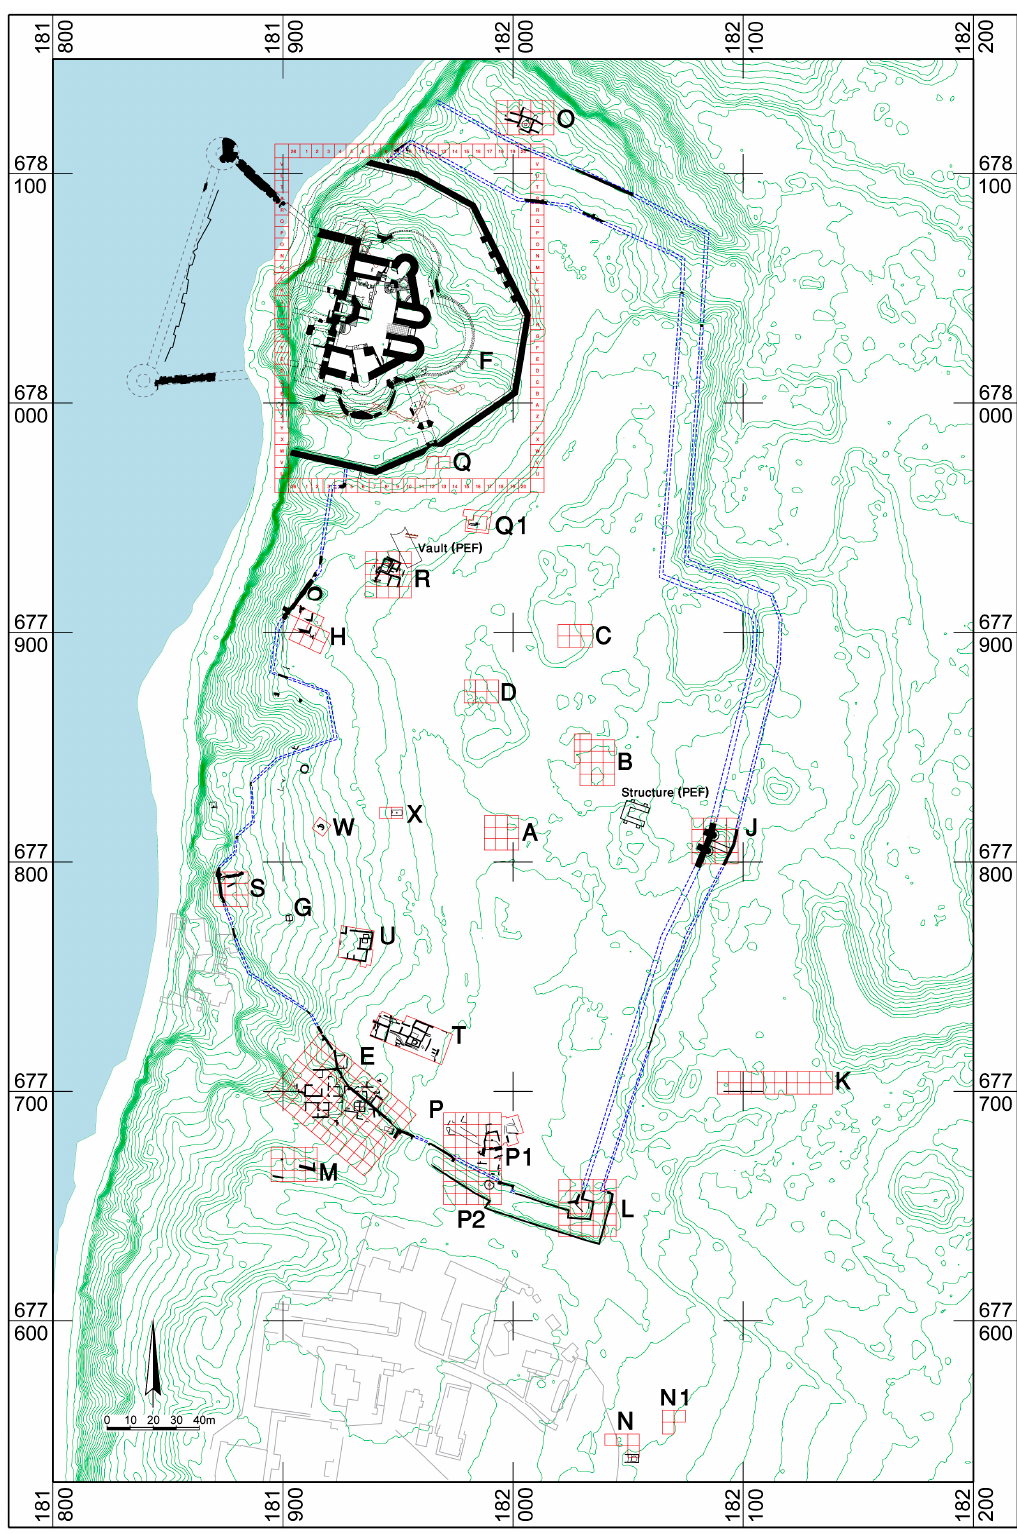
Figure 1. Apollonia-Arsuf, site plan of the medieval walled town (with indication of areas of excavations) (Slava Pirsky).